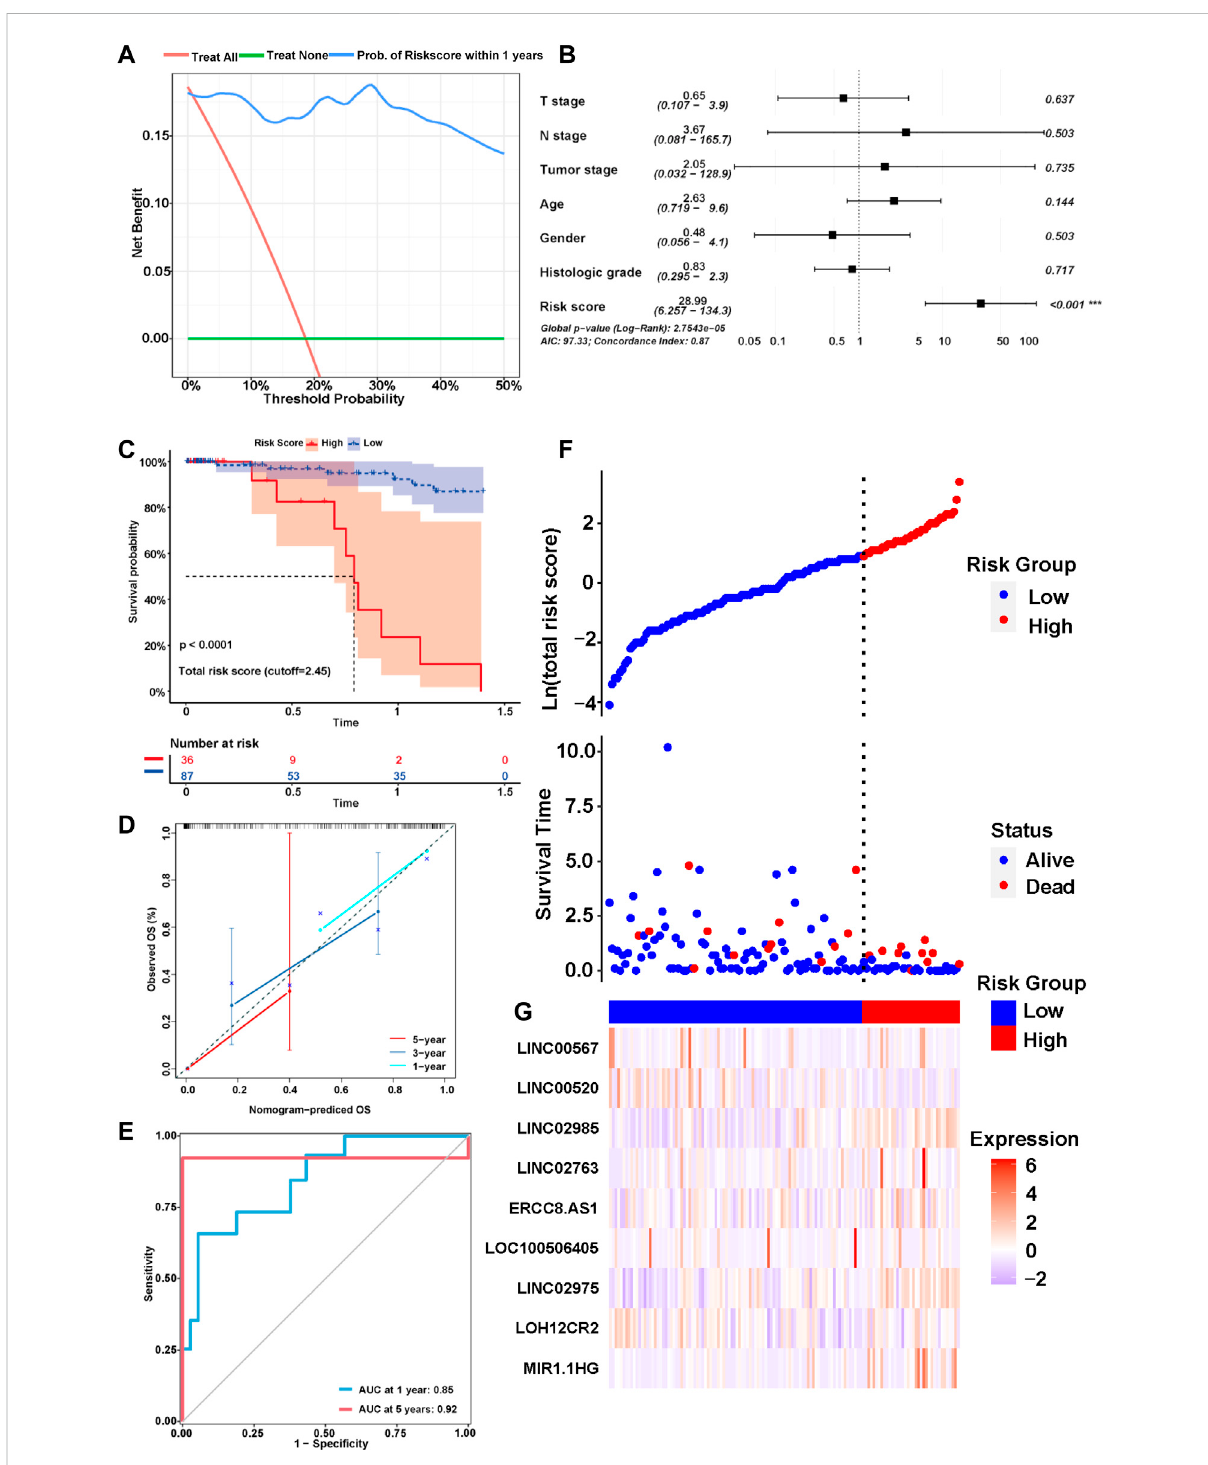
FIGURE 3 Identi fi cation of the prognostic signature in the training cohort. (A) Decision curve analysis (DCA) was conducted to con fi rm the superiority of the risk score. (B) Multivariable analysis was conducted to validate the independent prognosis value of the model in the training cohort. (C) Kaplan- MeierKaplan-Meier curves of the signature for predicting the overall survival (OS) of GC patients. (D) The calibration curves were constructed to determinetheaccuracyofthenomogramforOSat1,3and5 years. (E) Time-dependentROCcurveanalysisoftheriskmodelindifferentyears. (F,G) The distribution of the expression of the nine lncRNAs in the high- and low-risk groups.